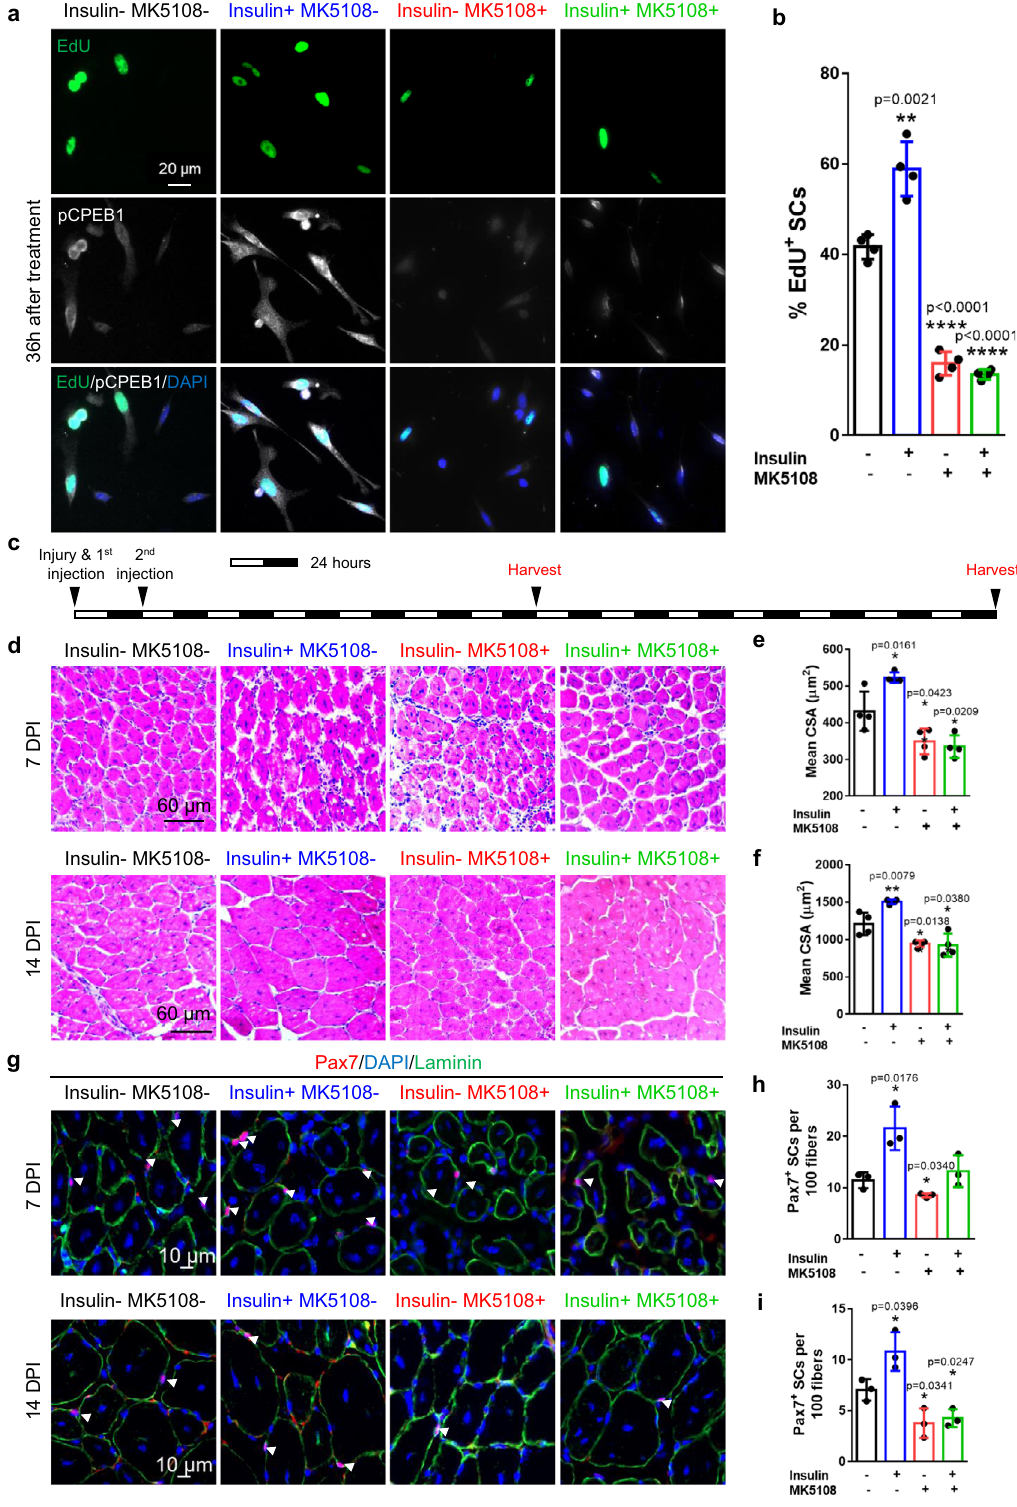
fi xation for 5min. PFA was subsequently quenched by 30 mL of 2 M glycine (Sigma – Aldrich, cat#G8898) perfusion for 5 min. In this manuscript, the SCs sorted from PFA-perfused muscle were termed as quiescent SCs (QSCs). Single muscle fi ber extraction . Extensor digitorum longus (EDL) muscles were dissected and digested in Ham ’ s F-10 medium with 800U/mL collagenase II for 85min in a shaking water bath at 37°C. To extract fi bers from perfused mice, the EDL muscles were digested with 1600 U/mL collagenase II. The fi bers were then